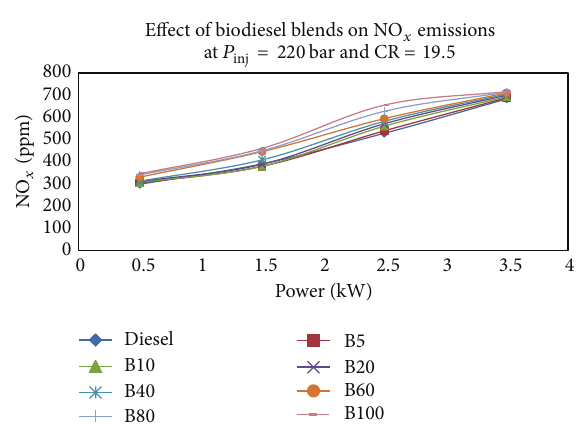
Figure 19: Variation in NO 𝑥 for various biodiesel blends at 𝑃 220 bar and CR